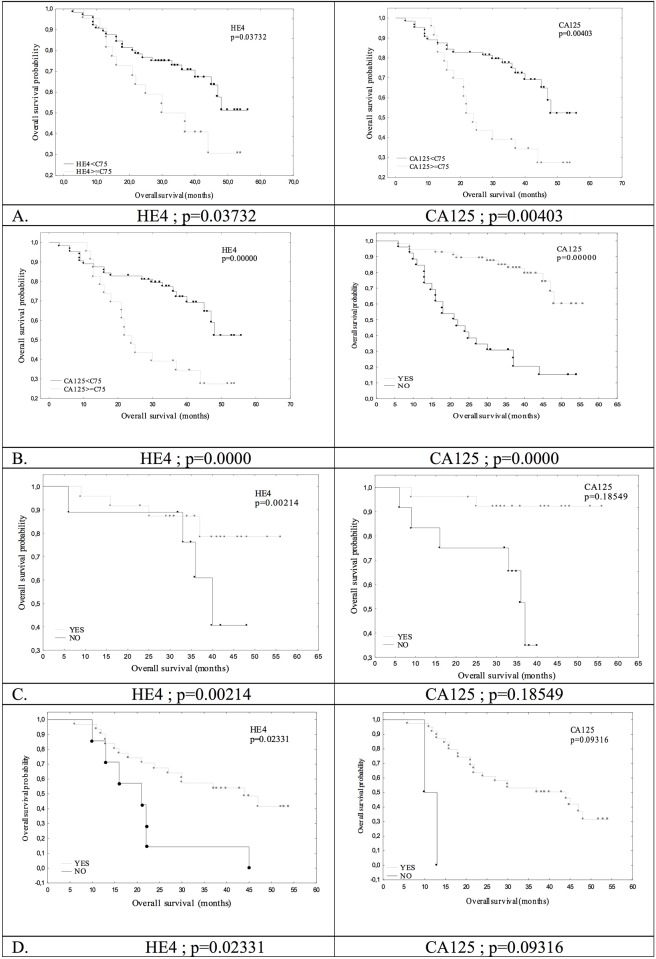
Overall survival stratified by HE4 and CA125 in the examined patients with ovarian cancer.(A) Stratified by preoperative serum marker levels (75 percentile) in the whole group. (B) Stratified by normalization after the last course of chemotherapy in the whole group. (C) Stratified by normalization of the serum marker levels after 3 courses of chemotherapy in patients after the primary debulking surgery. (D) Stratified by the 50% reduction of serum marker levels before the interval debulking surgery.